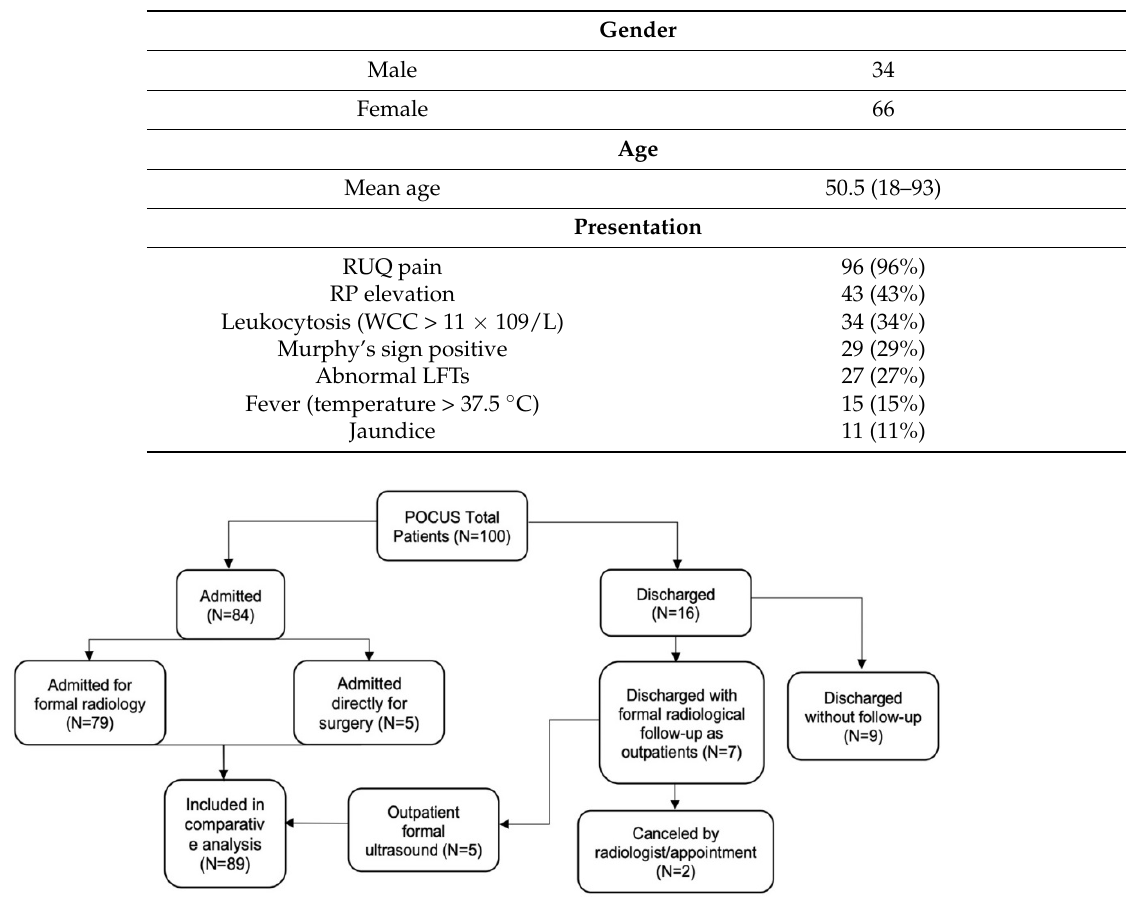
Table 1. Demographic Details.